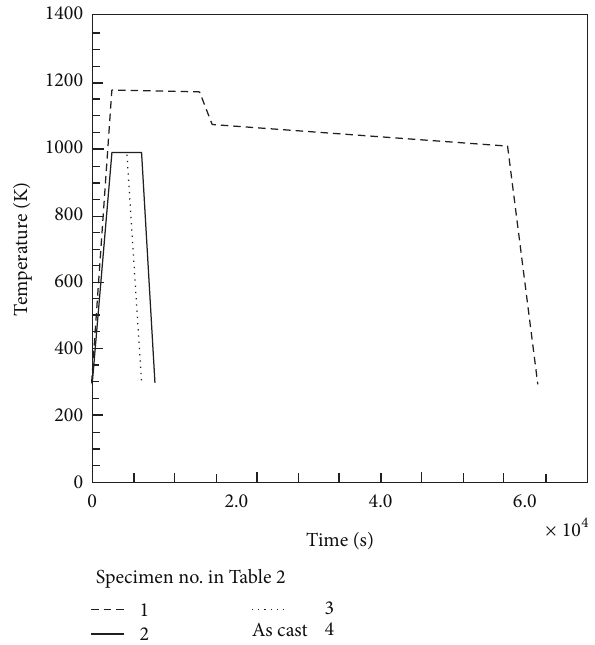
Figure 2: Heat treatment processes of